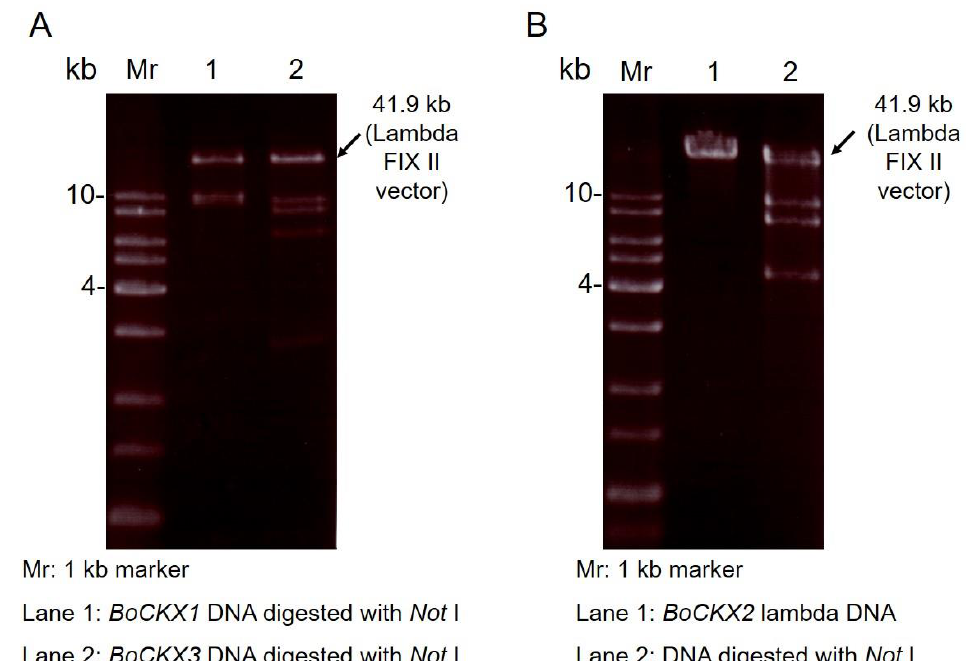
Figure 1. Three CKX genes were isolated by screening a bamboo genomic DNA Library. BoCKX1 ( A , lane 1), BoCKX2 ( B , lanes 1 and 2), and BoCKX3 ( A , lane 2) phagemids were purified and then digested by Not I. The size of the Lambda FIX II vector (41.9 kb) was indicated.